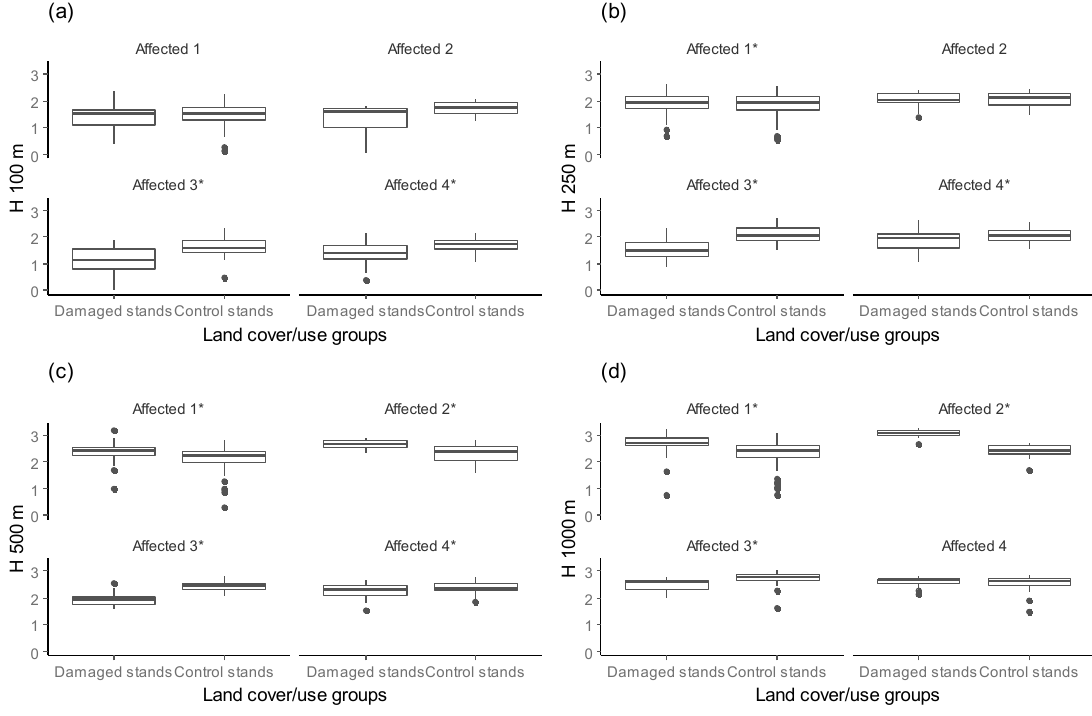
Figure 6. The Shannon diversity index (H) for forest cover types surrounding damaged and control stands within different buffer distances (( a ) H 100, ( b ) H 250, ( c ) H 500, ( d ) H 1000) in affected forest massifs ( * indicate significant difference using Kruskal-Wallis test; overall significance level = 0.05).